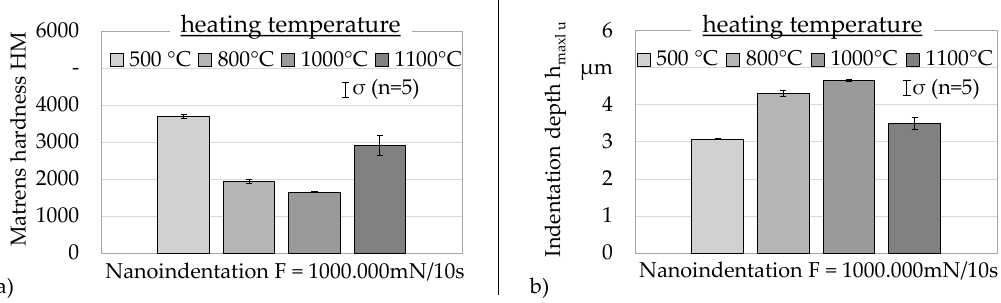
Figure 4. Exemplary results of microhardness measurement ( a ) indentation depth, ( b ) Martens hardness.